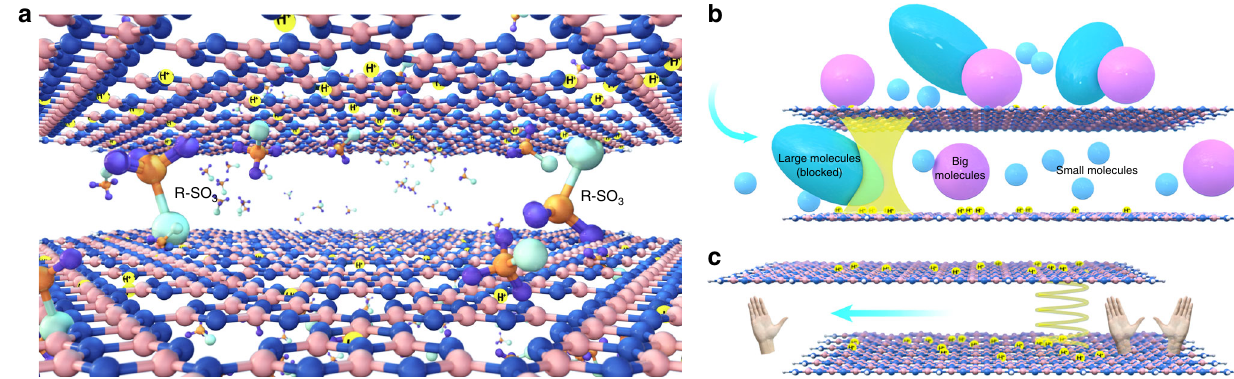
Fig. 1 Schematic illustration of GCN functionalization for selective permeation. a Precise interlayer distance control of protonated GCN with desired functionalities via anion intercalation strategy. R-SO 3 represents the anion of Brønsted acid or chiral organic acid, sulfate or (1R)-(-)-10-camphorsulfonate anion is utilized in this work. Orange, blue and azure balls in R-SO 3 denote S atom, O atom and remaining group in acid, respectively. Pink, dark blue and light yellow balls in GCN framework denote N atom, C atom and proton, respectively. b Sieving effect of solutes with different sizes over GCN-SA membrane. Light blue ellipse, pink and light blue balls denote large, big and small molecules, respectively. The yellow spring denotes the interlayer space in- between protonated GCN layers. c Enantioselective permeation effect of different enantiomers over GCN-CSA membrane. The yellow spiral denotes the chiral sites created in-between protonated GCN layers, the left and right hands denote a pair of enantiomer for enantioselective permeation. The arrows in b and c denote the permeation direction of various